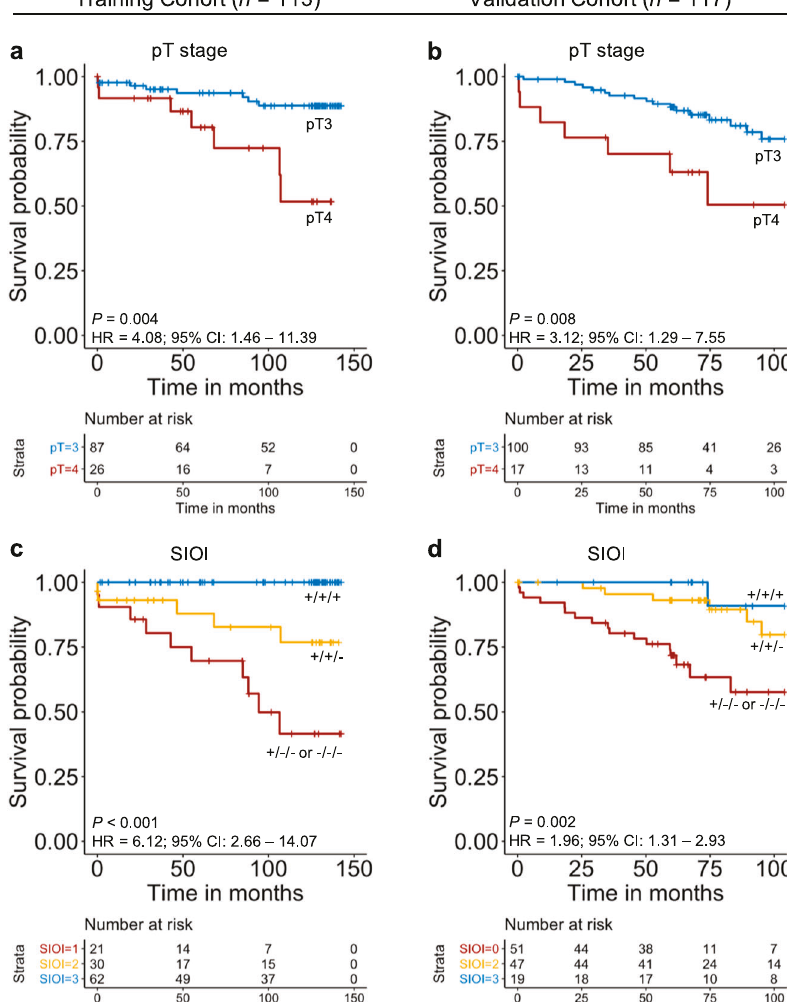
Fig. 4 KM survival analysis for pT stage and SIOI for training cohort (11.8-year follow-up) and validation cohort (8.6-year follow-up). a pT stage for training cohort. b pT stage for validation cohort. c SIOI for training cohort. d SIOI for validation cohort. The “ + / + / + ” category represents the group of patients who have CD3 + density in the IMCT above the cutoff point (389.6 cells/mm 2 ), average CD3 + CD8 + number within 0 – 50- μ m of TB above the cutoff point (4.1) and CD68 + /CD163 + ratio in the CT below the cutoff point (1.096); “ + / + / − ” group represents patients who are positive for only two of these features and “ + / − / − or − / − / − ” represents the group of patients who have only 1 or none of the above features. The HR is calculated using univariate Cox